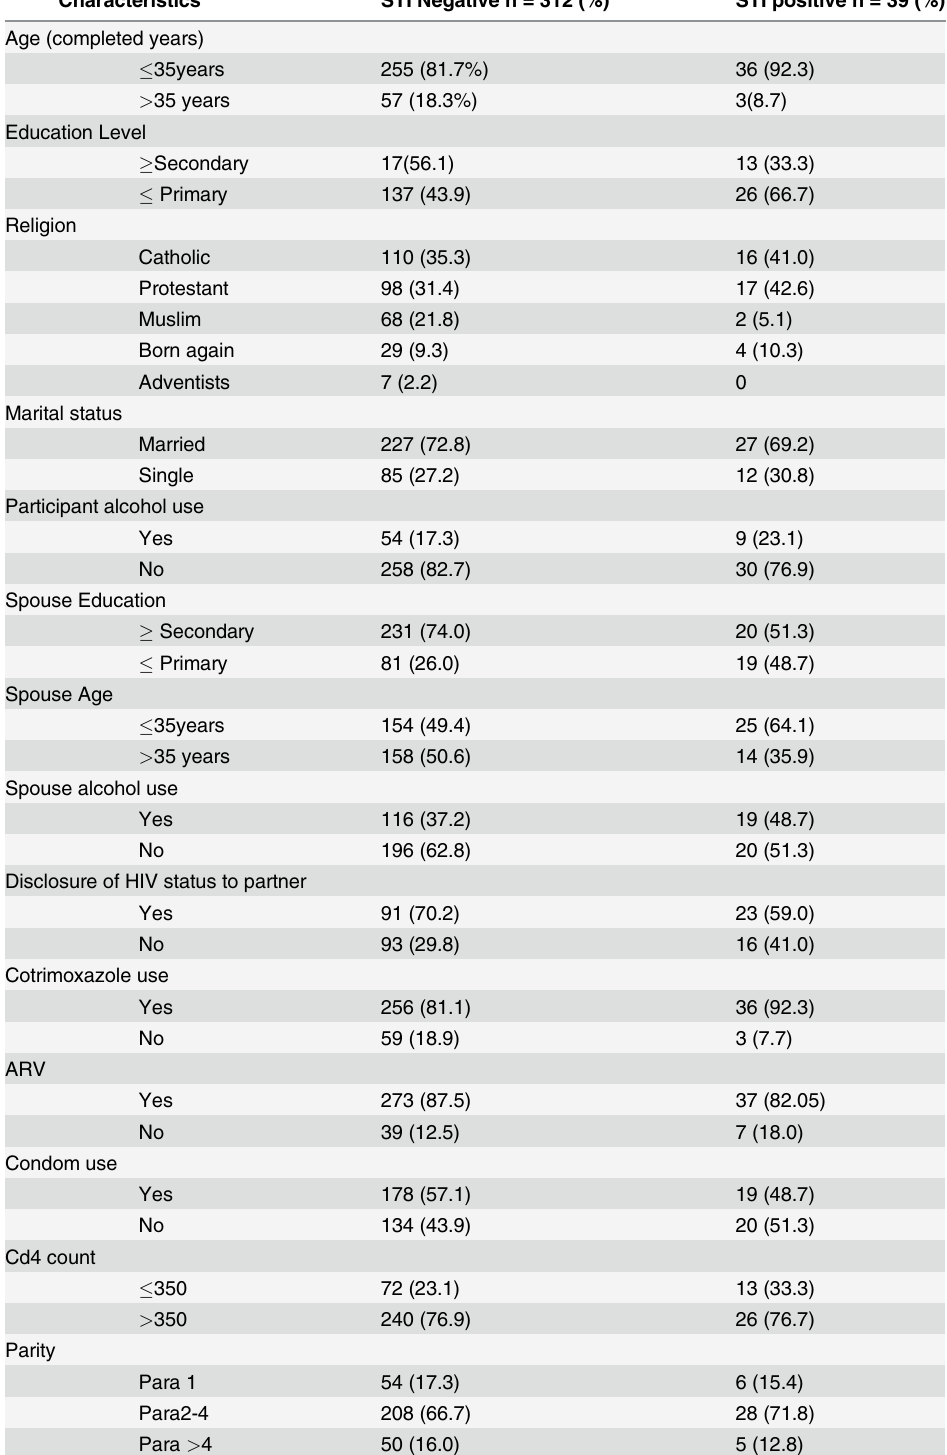
Table 1. Background characteristics of the 351women living with HIV opting for intrauterine contra- ception at Mulago